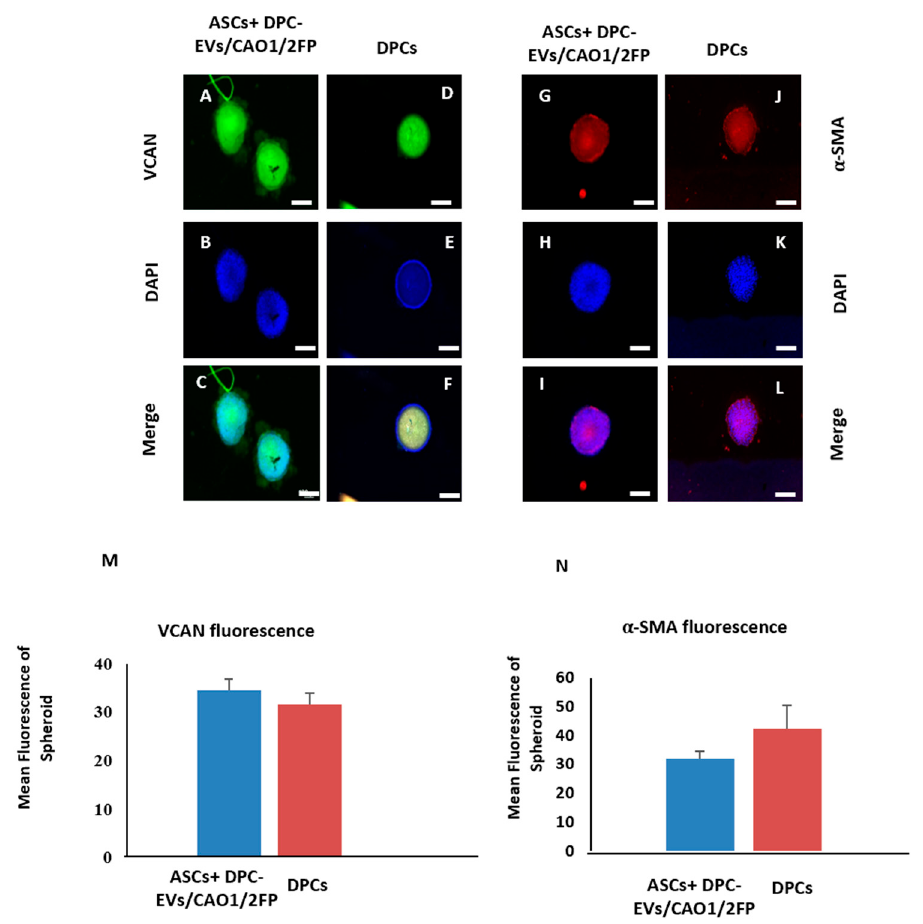
Figure 4. Immunofluorescence microscopic analysis of VCAN and α -SMA in dermal papilla cells (DPCs) and adipose-derived stem cells (ASCs) with dermal papilla cell-derived extracellular vesicles (DPC-EVs) spheroids. ( A – L ) Representative photograph of cells in each category, stained with anti- VCAN and α -SMA antibodies. ( M , N ) Quantitative histograms of VCAN and α -SMA fluorescence intensity in spheroids were made using the Image J software 1.8.0_172. The white scale bar represents 200 µ m. Data are presented as the mean value ± SD (Error Bars) and showed no significant difference between the two groups.